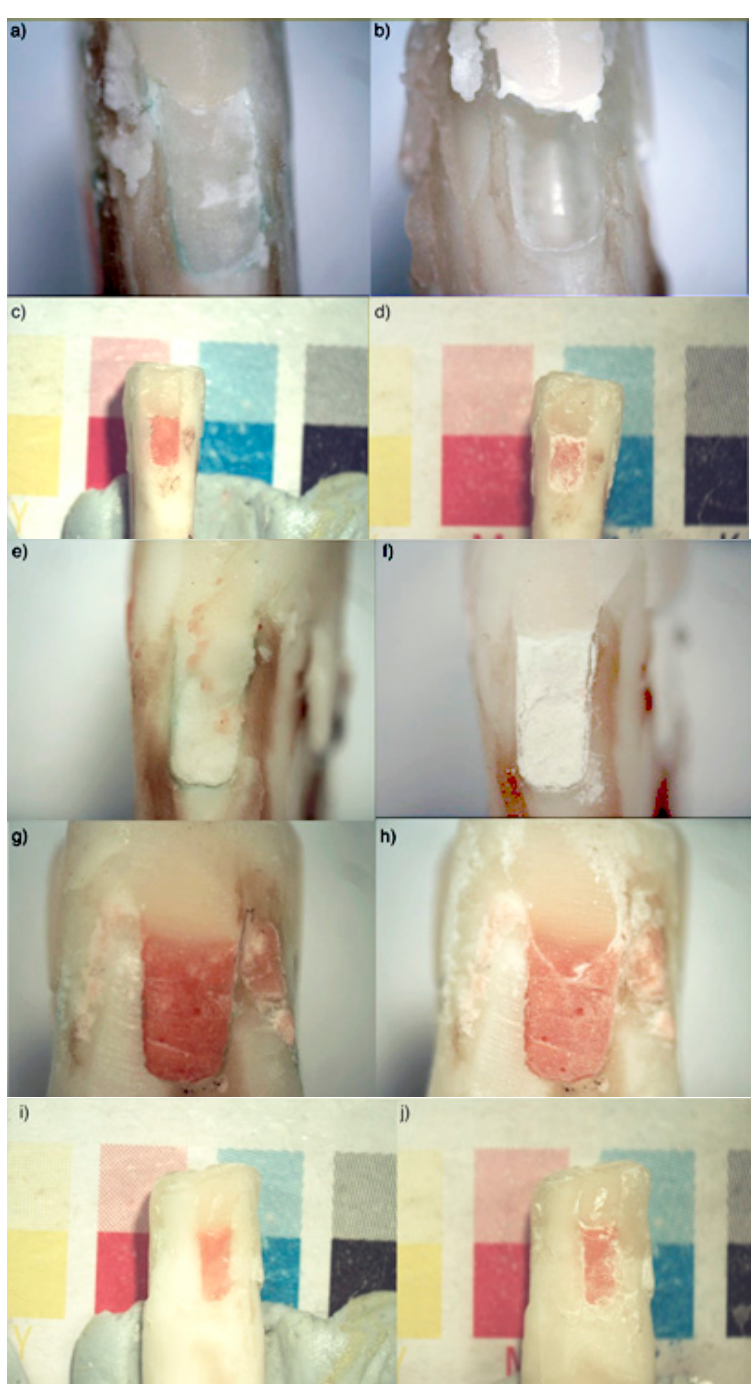
Figure 3. Open sandwich Class II restorations on bovine teeth, before ( left ) and after ( right ) 7 days of exposure. ( a , b ) GC Equia ® Forte Fil (EFF) with citric acid, showing considerable surface loss. ( c , d ) GC Fuji ® VII (F7) with phosphoric acid. The color is lighter. ( e , f ) GC Equia ® Forte Fil (EFF) with phosphoric acid, showing surface irregularities in the form of pitting, cracking and roughness. ( g , h ) GC Fuji ® VII (F7) with lactic acid, showing increased whiteness at the restoration margin. ( i , j ) GC Fuji ® VII (F7) with phosphoric acid. The adjacent dentin border shows increased whiteness.